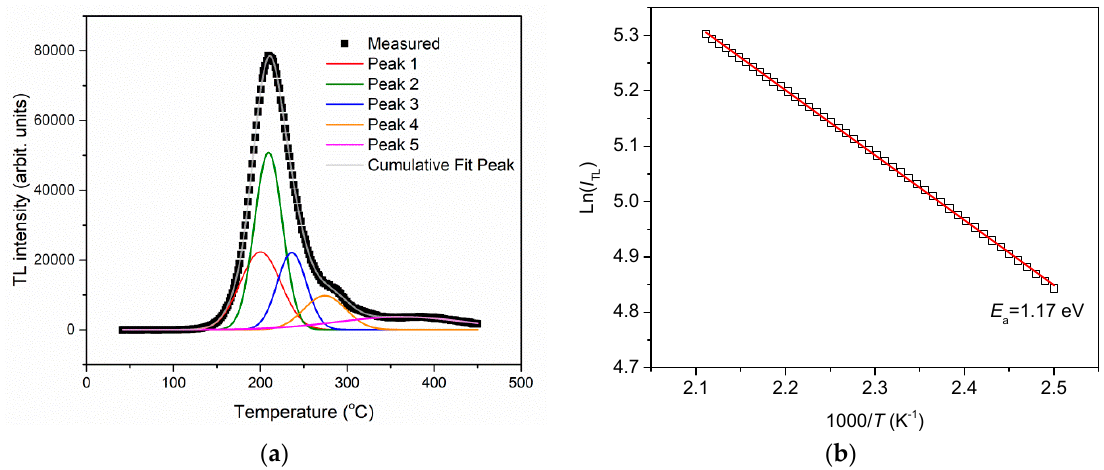
Figure 6. (a) CGCD of the TL glow curve of the ZnB 2 O 4 :0.03Tb 3+ sample for a 30 Gy. (b) TL intensity Figure 6. ( a ) CGCD of the TL glow curve of the ZnB 2 O 4 :0.03Tb 3 + sample for a 30 Gy. ( b ) TL intensity versus 1000/T. Open shapes and lines present the experimental data and theoretical fit, respectively. versus 1000 / T. Open shapes and lines present the experimental data and theoretical fit,